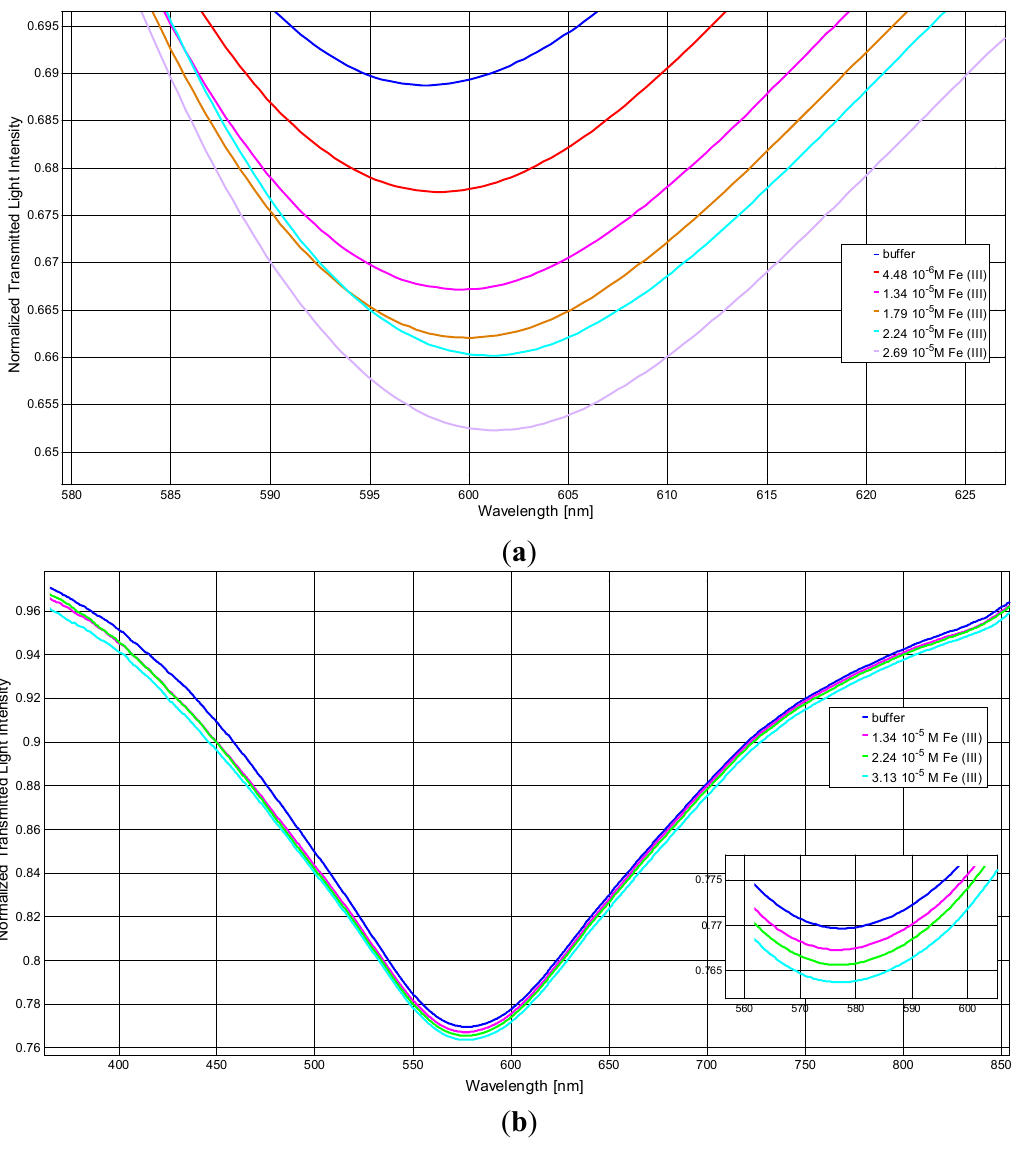
at increasing 3